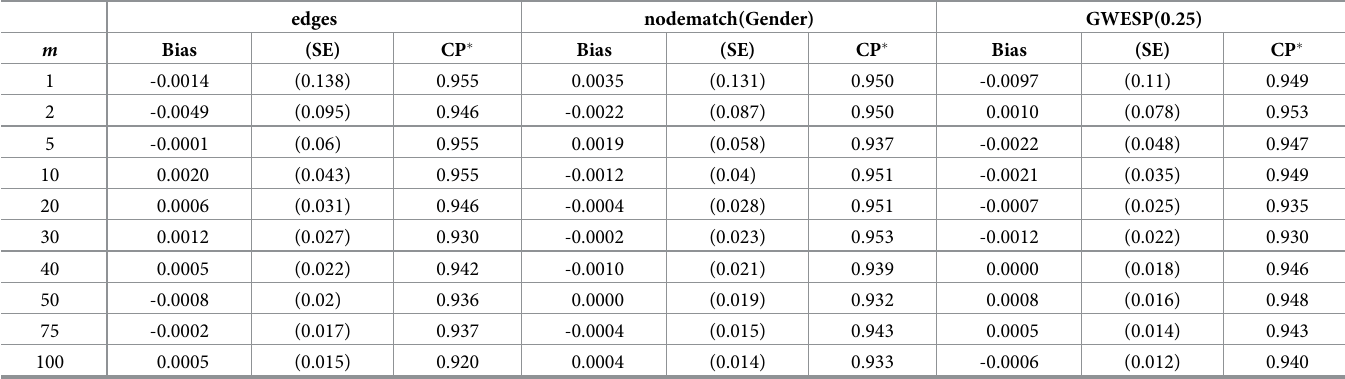
Table 1. Pooled MLE bias, standard error, and coverage rates of 95% Wald confidence intervals as a function of sample size.